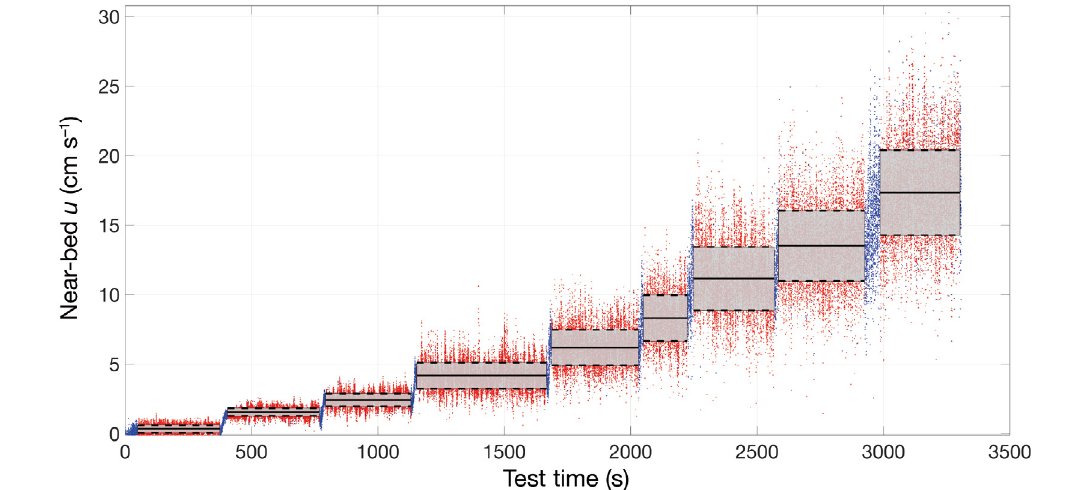
Fig. 5. Raw (blue) and processed (red) velocity records for the main velocity component during a test over muddy substrate. The black lines and grey boxes indicate the mean ± SD of the corrected values, representing the constant motor power